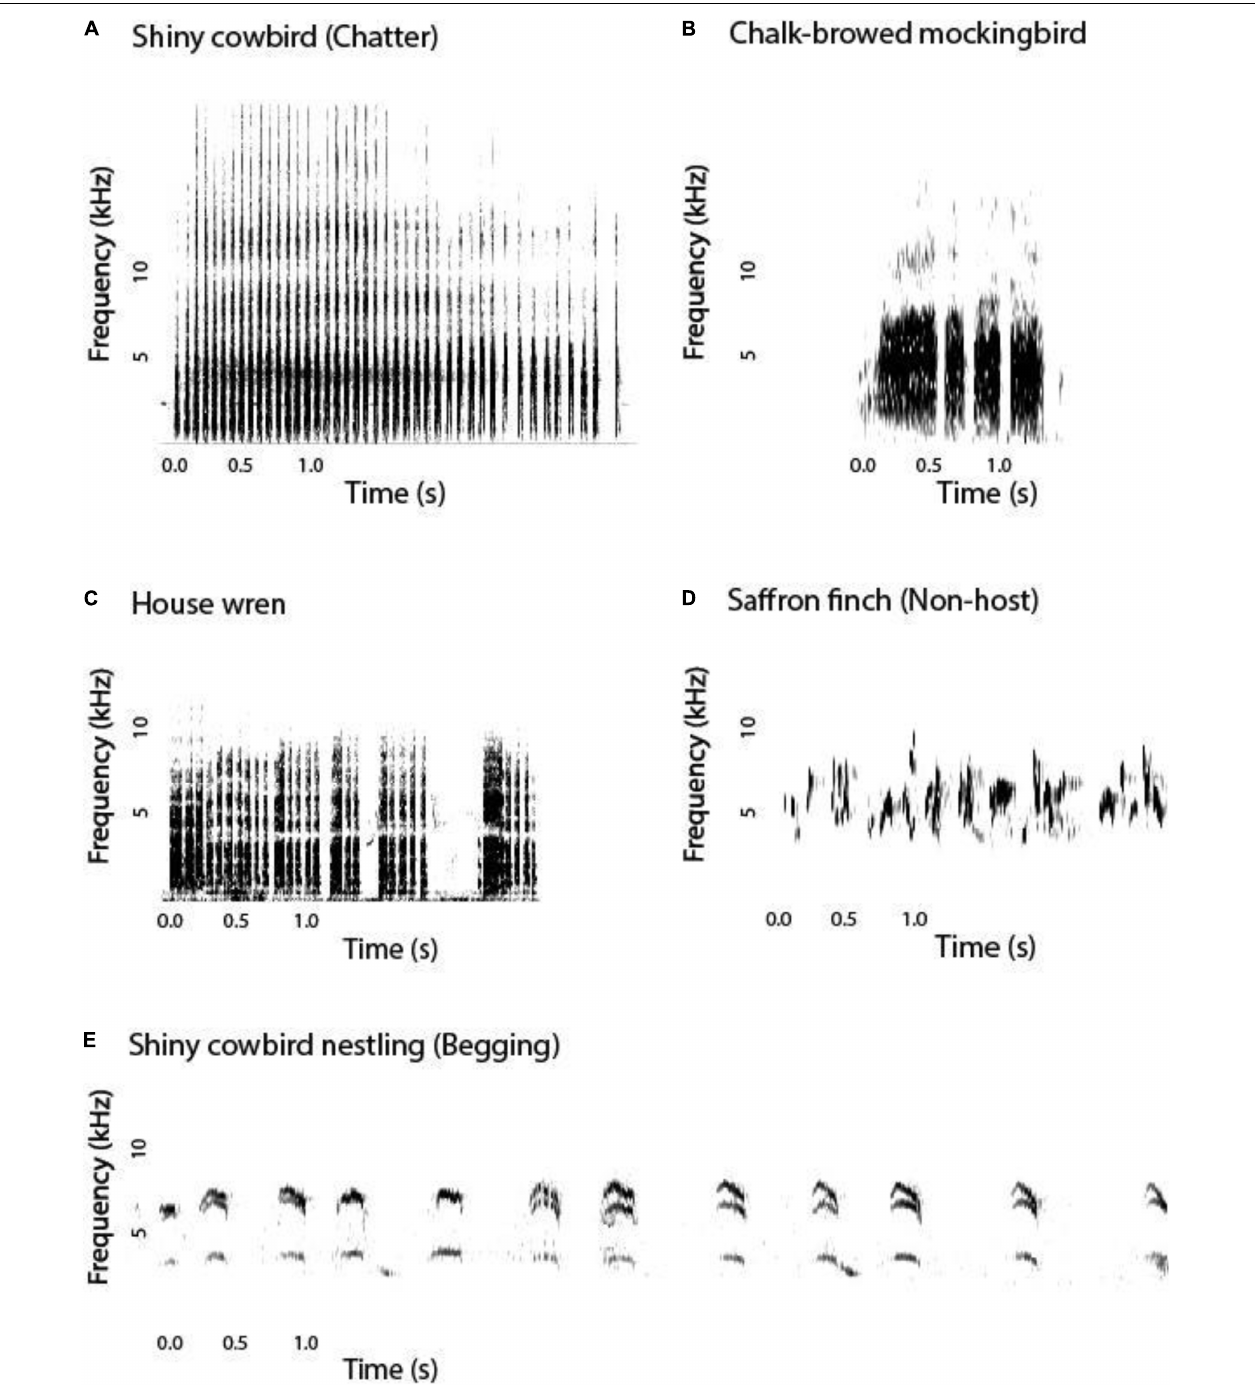
FIGURE 1 | Representative sonograms of the playbacks used in the experiments and of the shiny cowbird begging. (A) Chatter call of a female shiny cowbird ( Molothrus bonariensis ), (B) call of an adult chalk-browed mockingbird ( Mimus saturninus ), (C) call of an adult house wren ( Troglodytes aedon ), (D) call of an adult saffron finch ( Sicalis flaveola , i.e., nonhost species), and (E) begging of a shiny cowbird chick.